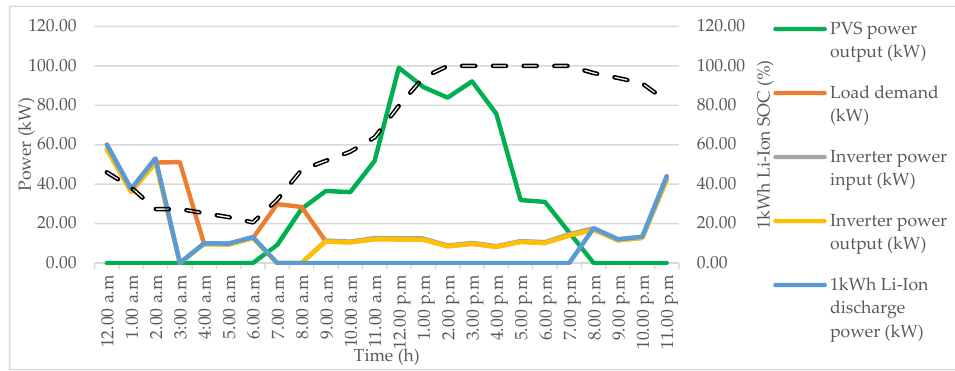
Figure 14. Inverter operation for the month of June. Figure 14.